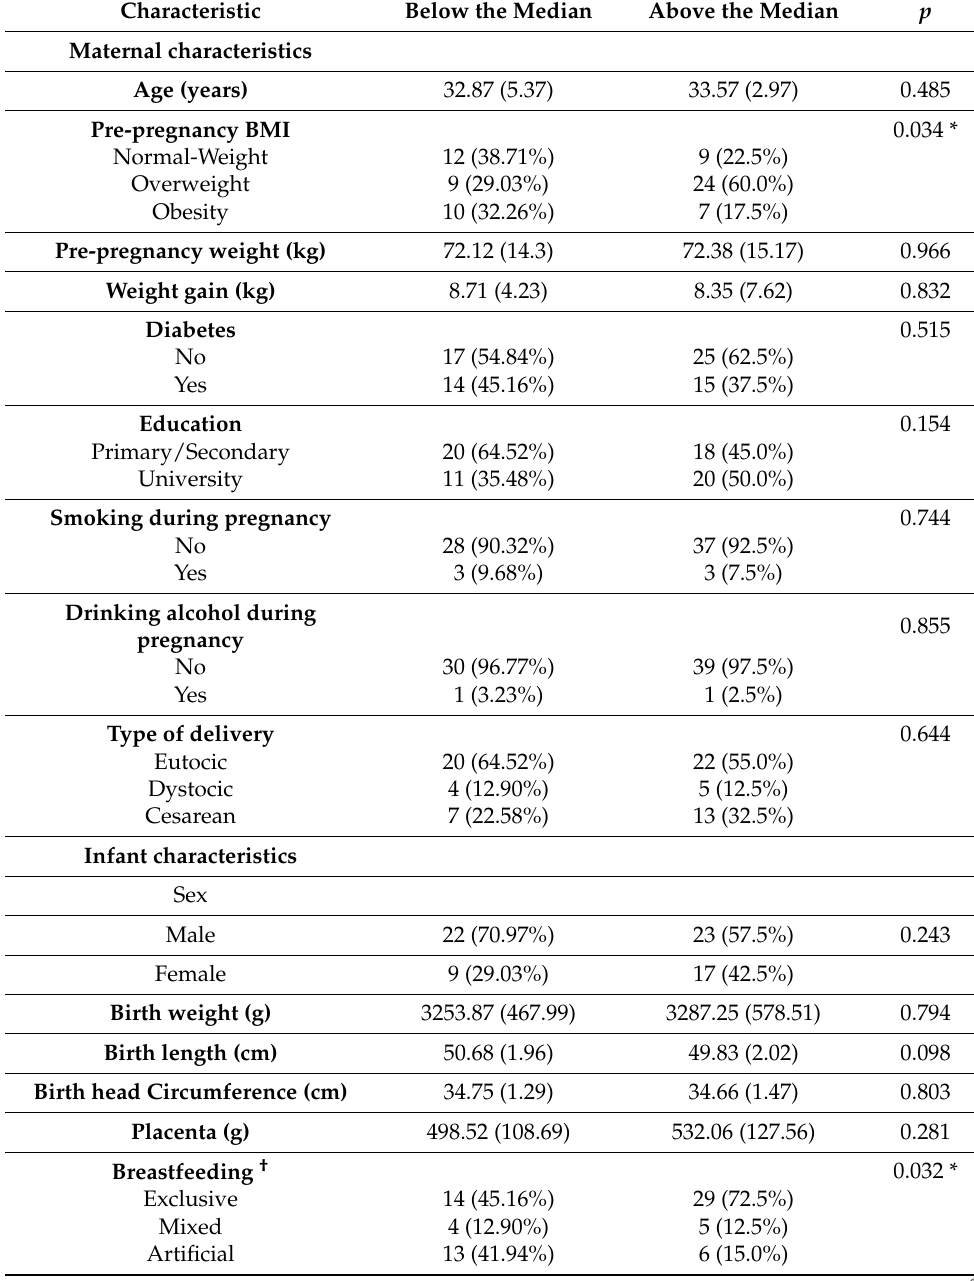
Table 1. Characteristics of the population according to the dichotomization between Fine Motricity Scores from the Bayley ®